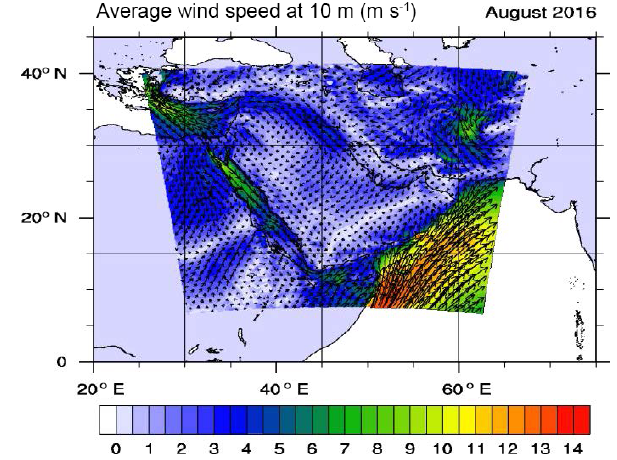
Figure 3. Average wind speed (color scale) and vectors from NMME-DREAMv1.0 for August